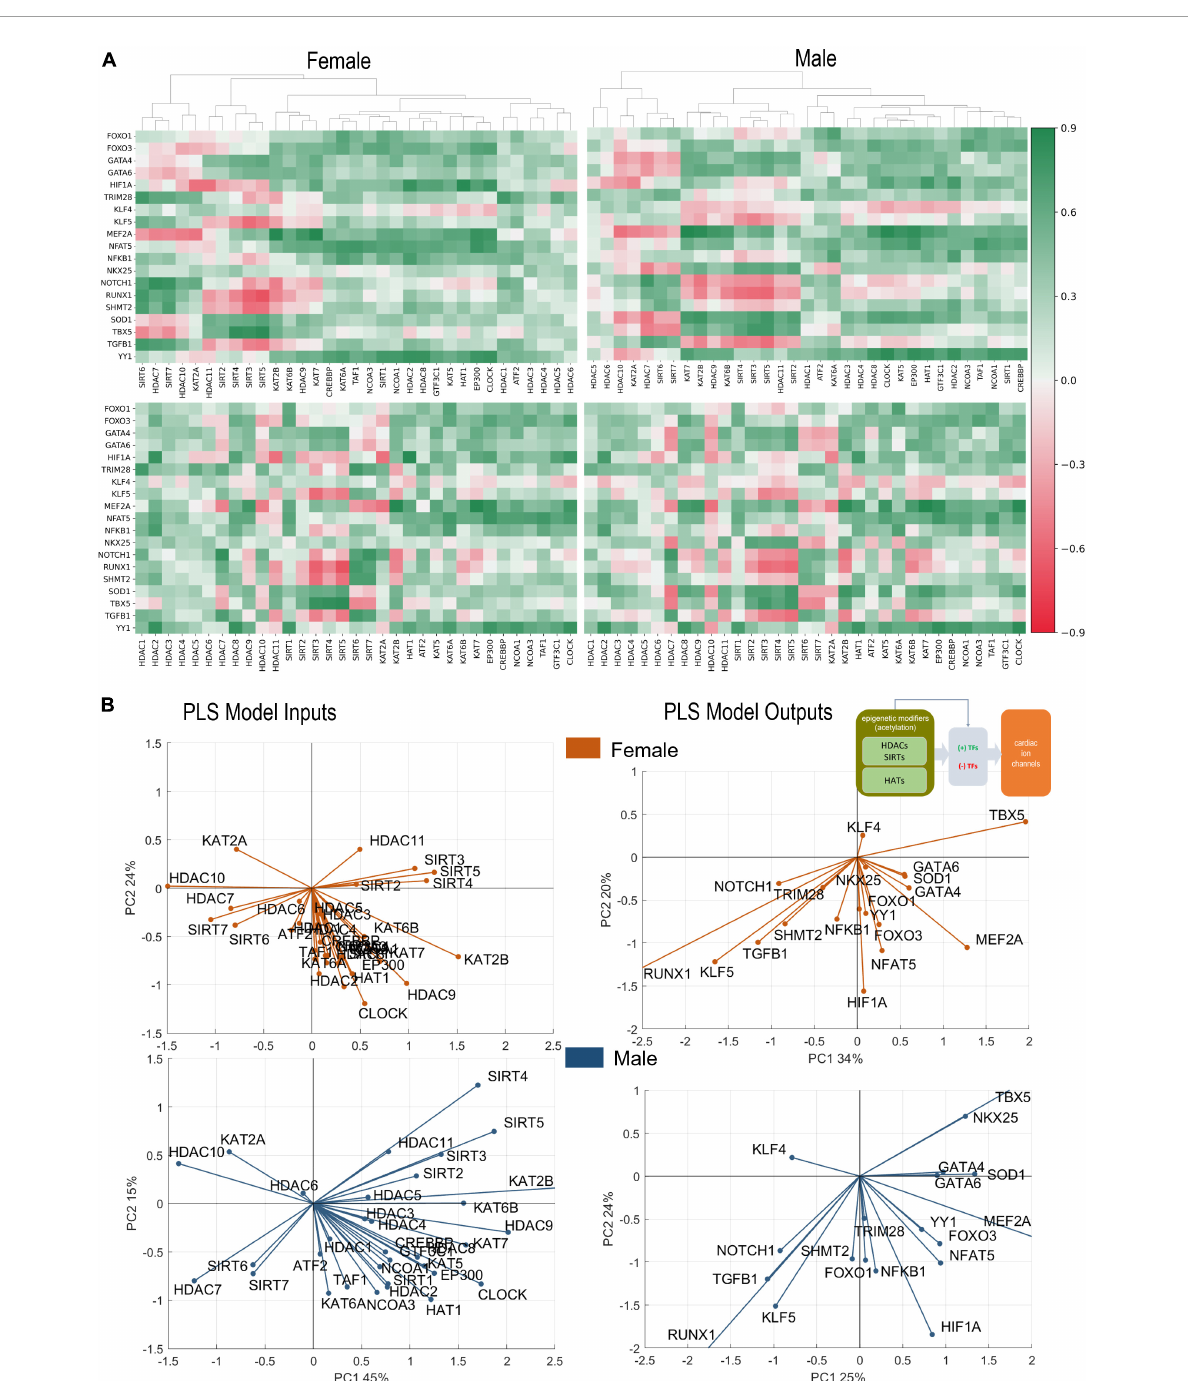
FIGURE3 Analysis of links between acetylation modifiers (HDACs, SIRTs, and HATs) and key cardiac TFs. (A) Pearson’s correlation of TFs with HDACs, SIRTs, and HATs for female (top) and male (bottom) LV heart samples. Positive/negative correlations are coded in green/red and shaded by their strength. The linkages in the top clustering’s were created using agglomerative clustering. (B) PLS regression models for female (orange) and male (blue) samples. Inset in B shows the models being investigated. Shown are biplots for the PLS models—constructed as described in Figure 2